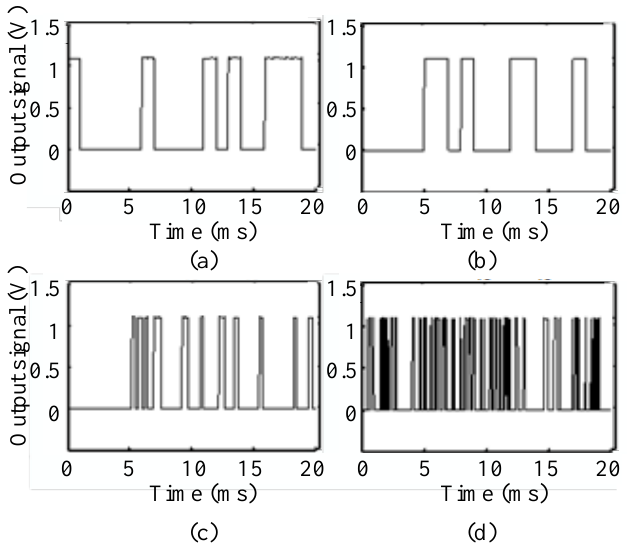
Figure 11. Digital-analog mixed post-simulation waveform.